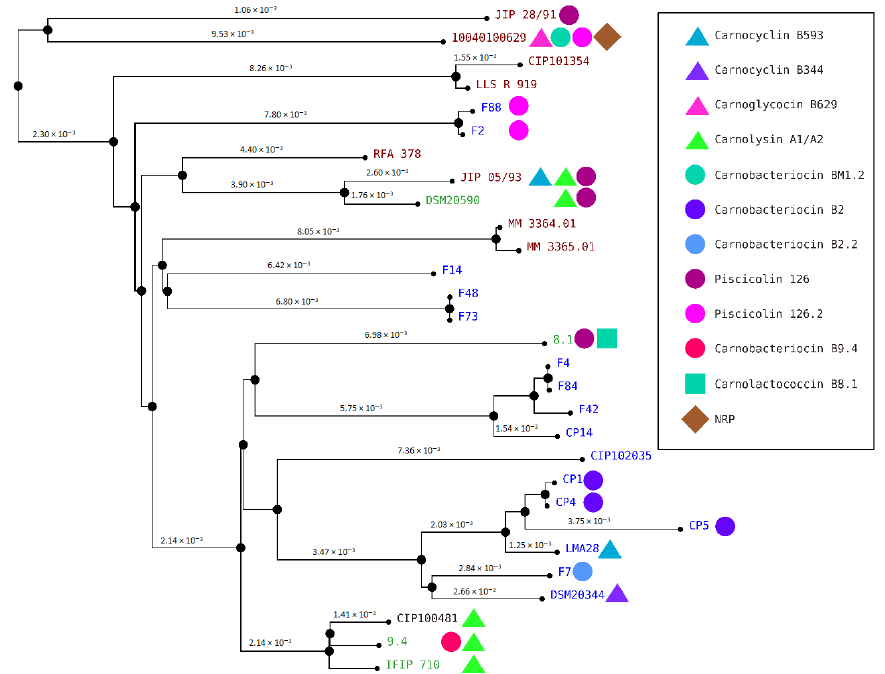
Figure 9. C. maltaromaticum genome clustering. The names of the C. maltaromaticum strains are indicated, in blue, green, dark red, and black when the strains were isolated from a dairy product, other food products, diseased fish, and human blood, respectively. Next to strain names, the symbols indicate the bacteriocin and the NRP predicted from the genome of the strains. The bacteriocin BM1 is not